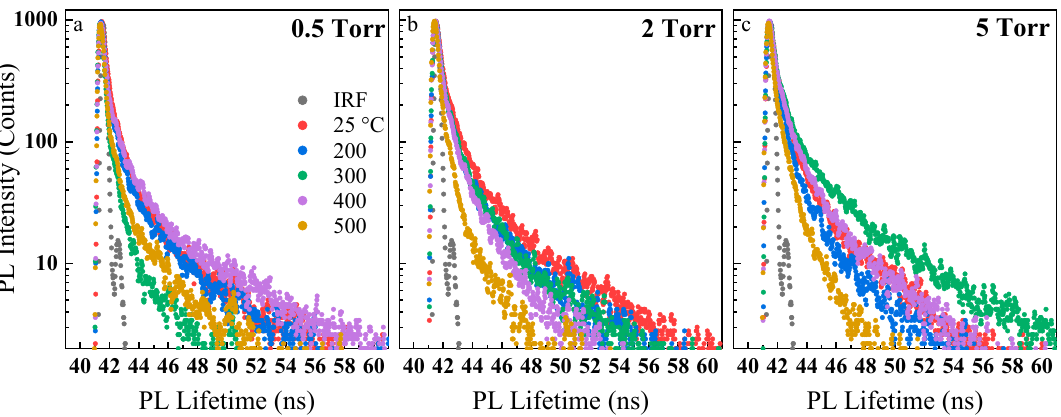
Figure 7. PL lifetime showing the effect of baking temperature on the nanoparticles deposited at the indicated pressure ( a – c ). The overall trend shows that the PL lifetime decreases as the baking temperature increases.